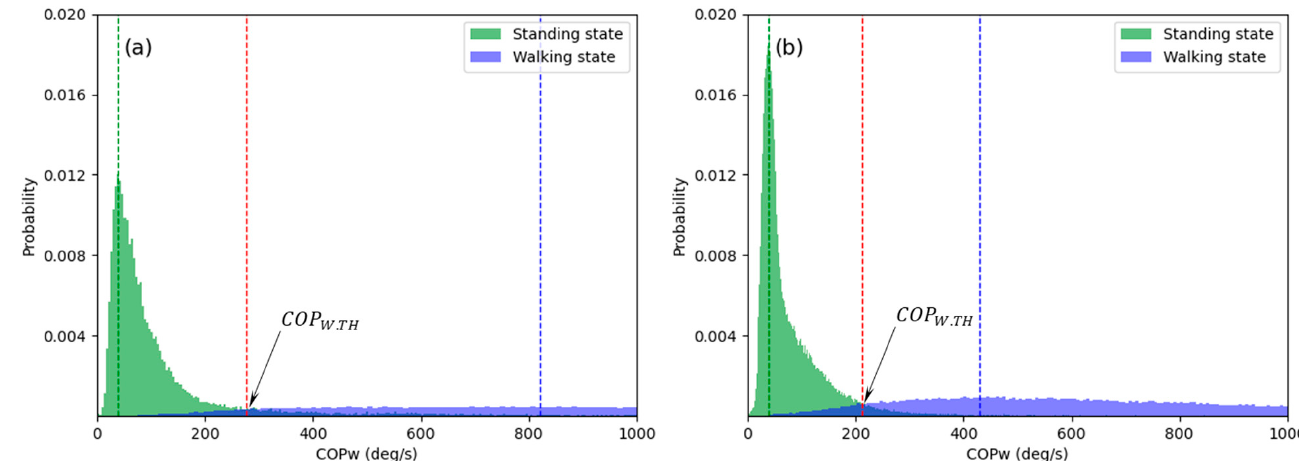
. COP ( COP W ): ( a ) healthy adults ( b ) patients. Figure 4. Histograms of the waveform length of Figure 4. Histograms of the waveform length of COP(cid:4662) ( 𝐶𝑂𝑃 (cid:3024) ): ( a ) healthy adults ( b ) patients